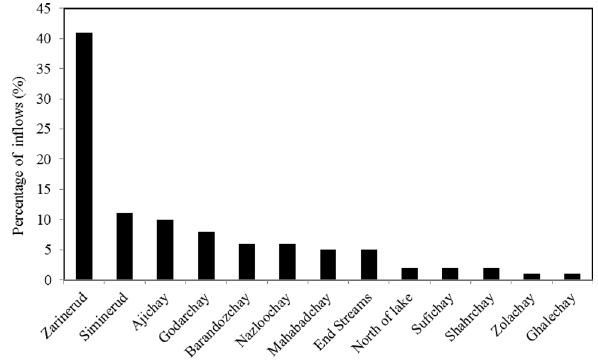
Figure 2. Contribution percentages of Lake Urmia water inflows.